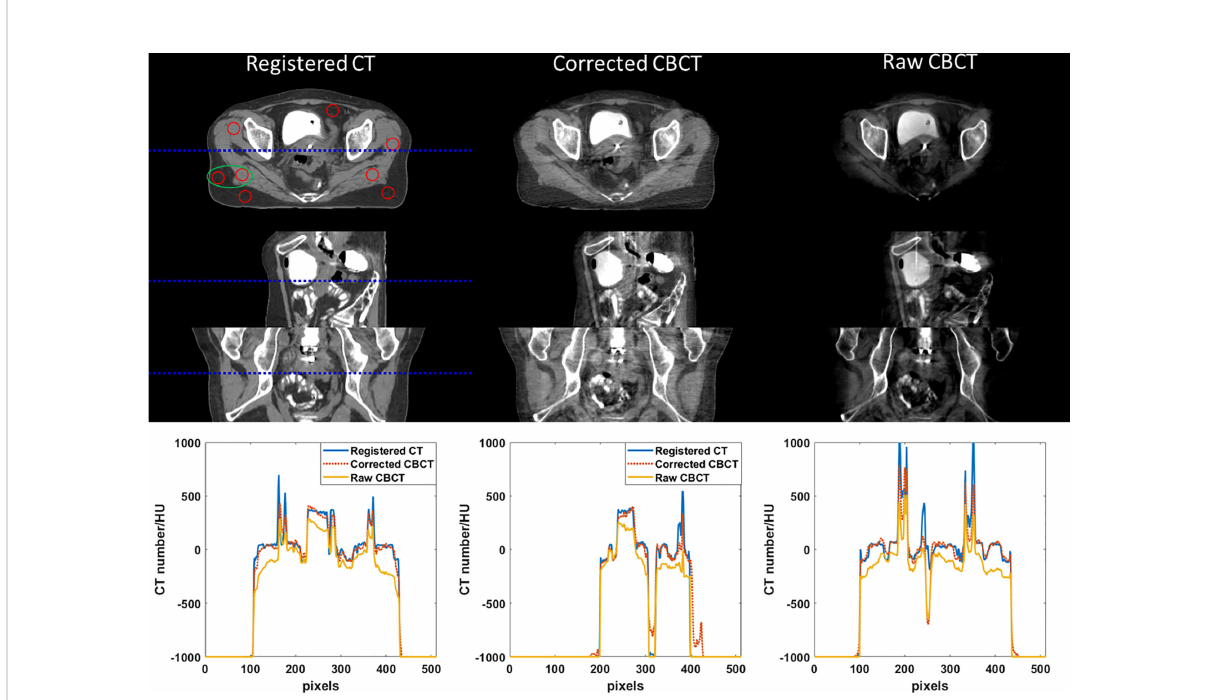
FIGURE 6 CT/CBCT images of one BT patient. The fi rst three rows display the coronal, sagittal, and axial views from top to bottom; display window: [ − 200 300] HU. The 1D pro fi les indicated by the dotted lines are displayed in the last row. The mean CT number and SNU are calculated in the circle areas, and the CNR is calculated in the ellipse